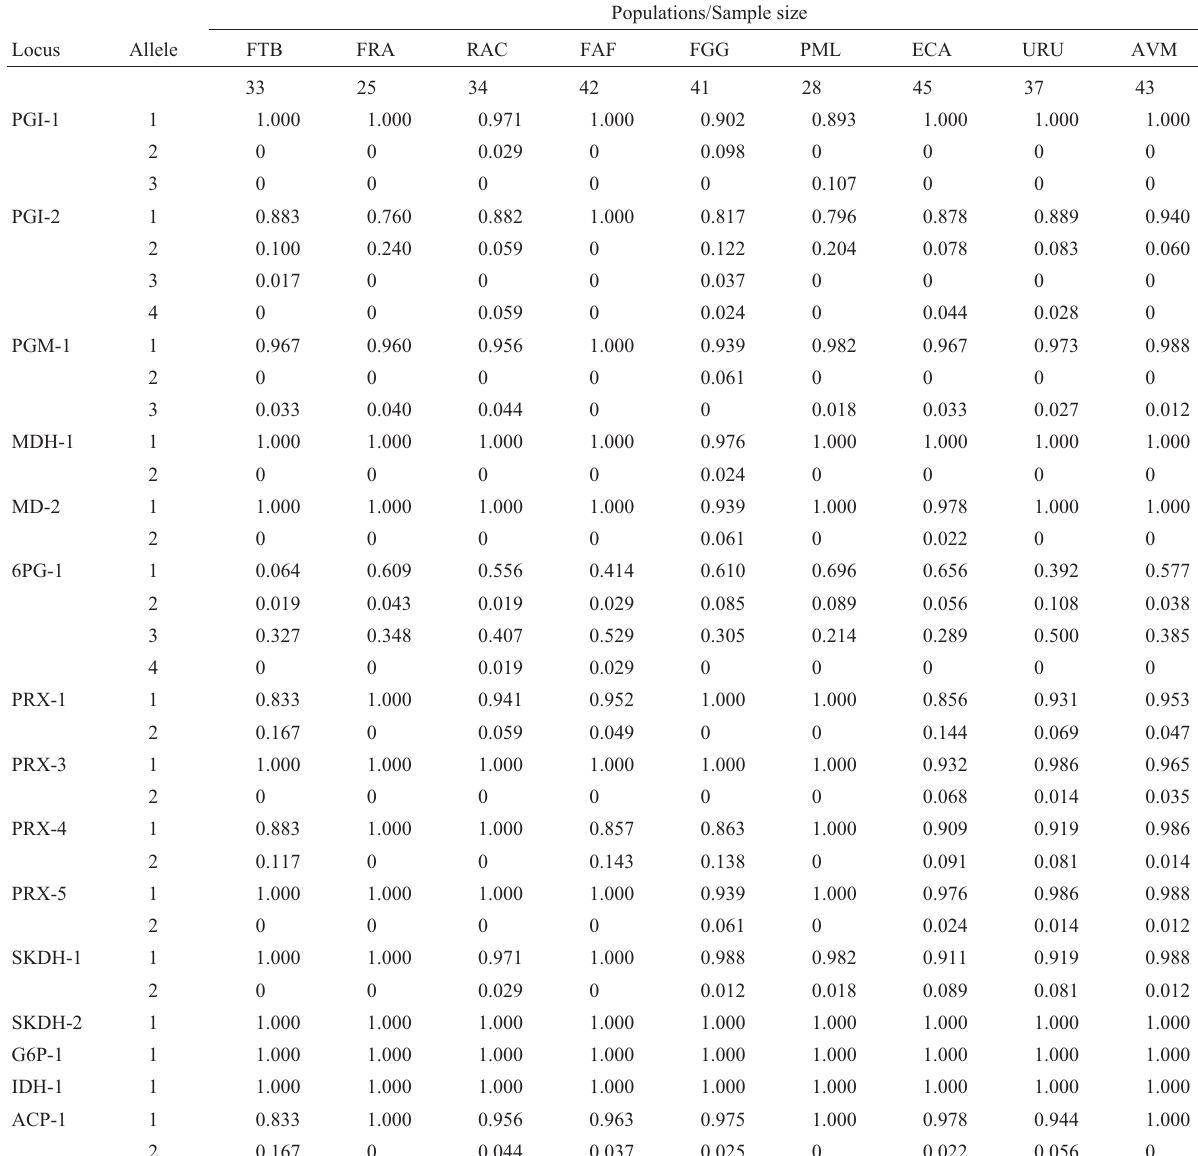
Table II - Allelic frequencies for 15 allozymic loci analyzed in 328 individuals of nine populations of Araucaria angustifolia in Santa Catarina. Populations/Sample